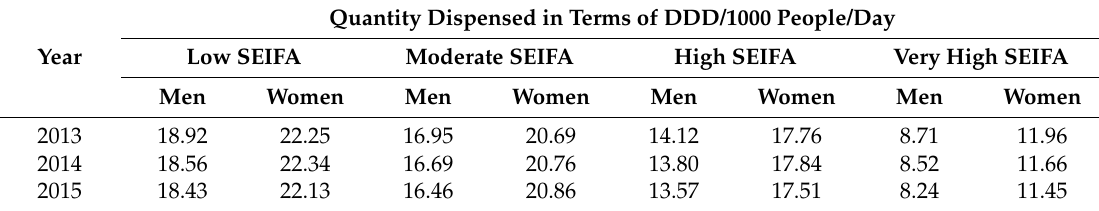
Table 2. Opioids dispensed over the years, across SEIFA level for men and women.